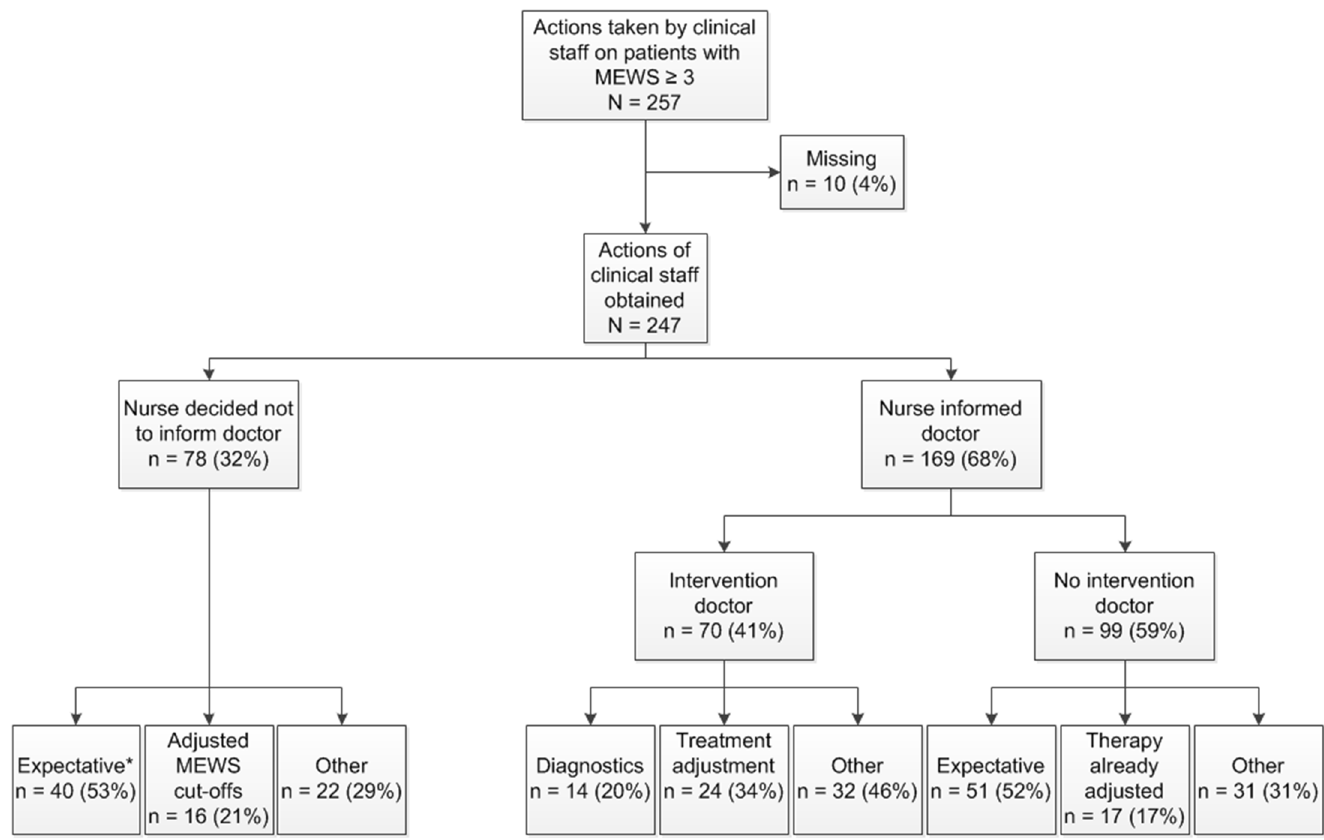
Fig 3. Actions undertaken on patients by clinical staff after critical score reached. N = number of MEWS measurements (cid:1) 3. * Expectative since this high score is expected as a result of the (known) disease process or the treatment.